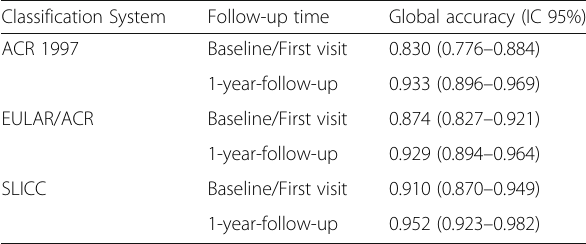
Table 3 Global accuracy for ACR 1997, SLICC and the new EULAR/ACR criteria, at baseline/first visit and 1-year-follow-up Classification